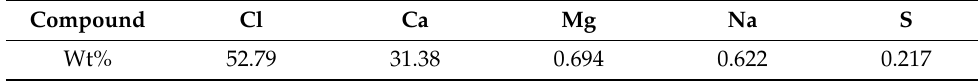
Table 4. Chemical composition (%) of CaCl 2 · 2H 2 O as analyzed by XRF.